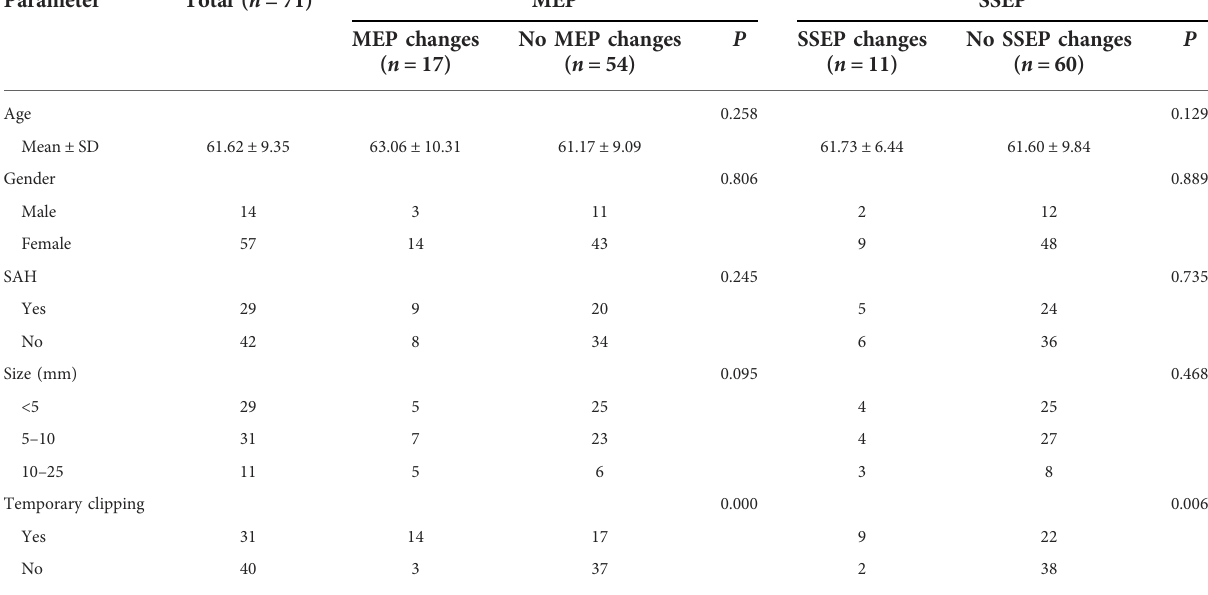
TABLE 1 Clinical characteristics of 71 patients with posterior communicating artery aneurysm.